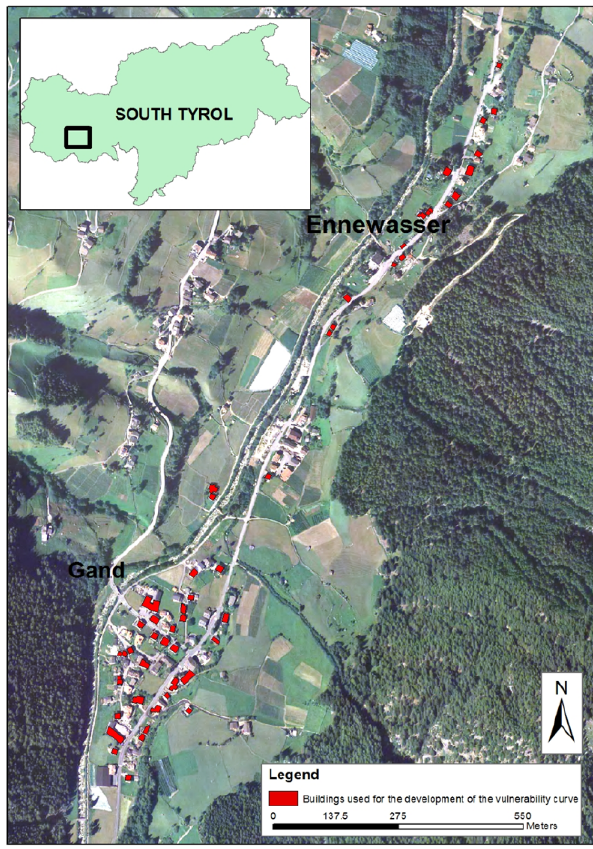
Figure 3. The case study area: municipality of Martell (villages of Gand and Ennewasser). The buildings used in the case study are highlighted in red colour.